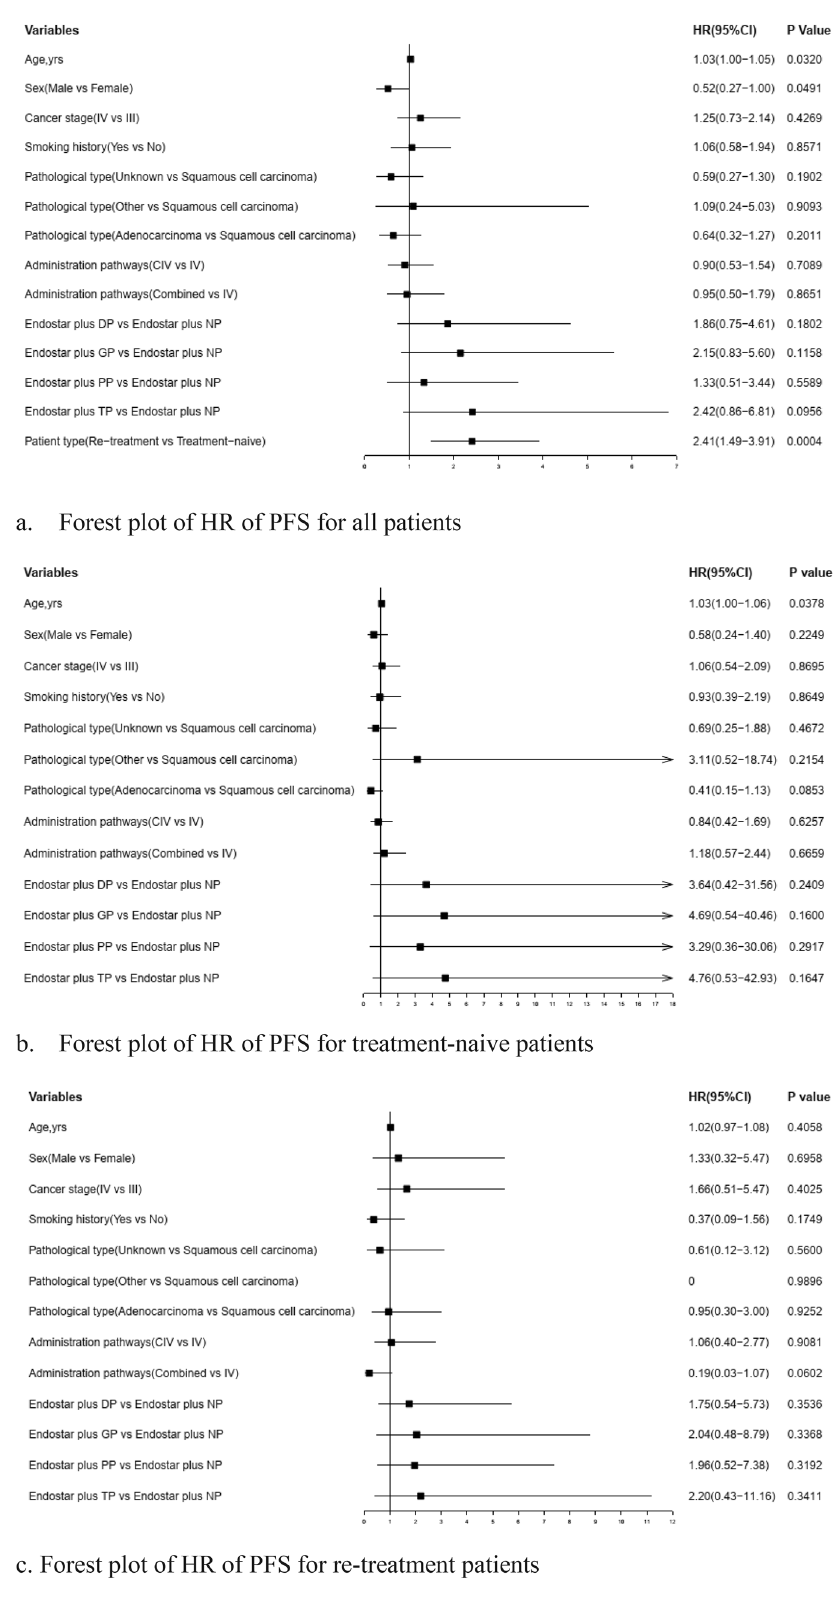
Figure 1. Forest plot of HR of PFS for all patients and subgroup